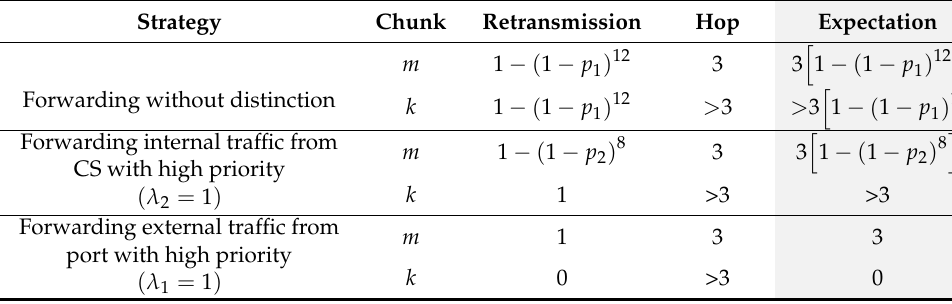
Table 2. The probability and expectation of retransmission for chunk m and k